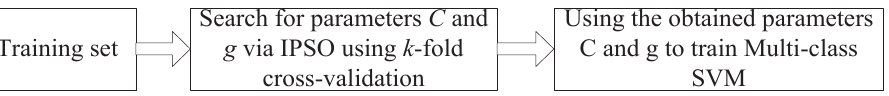
Figure 6. The flow of